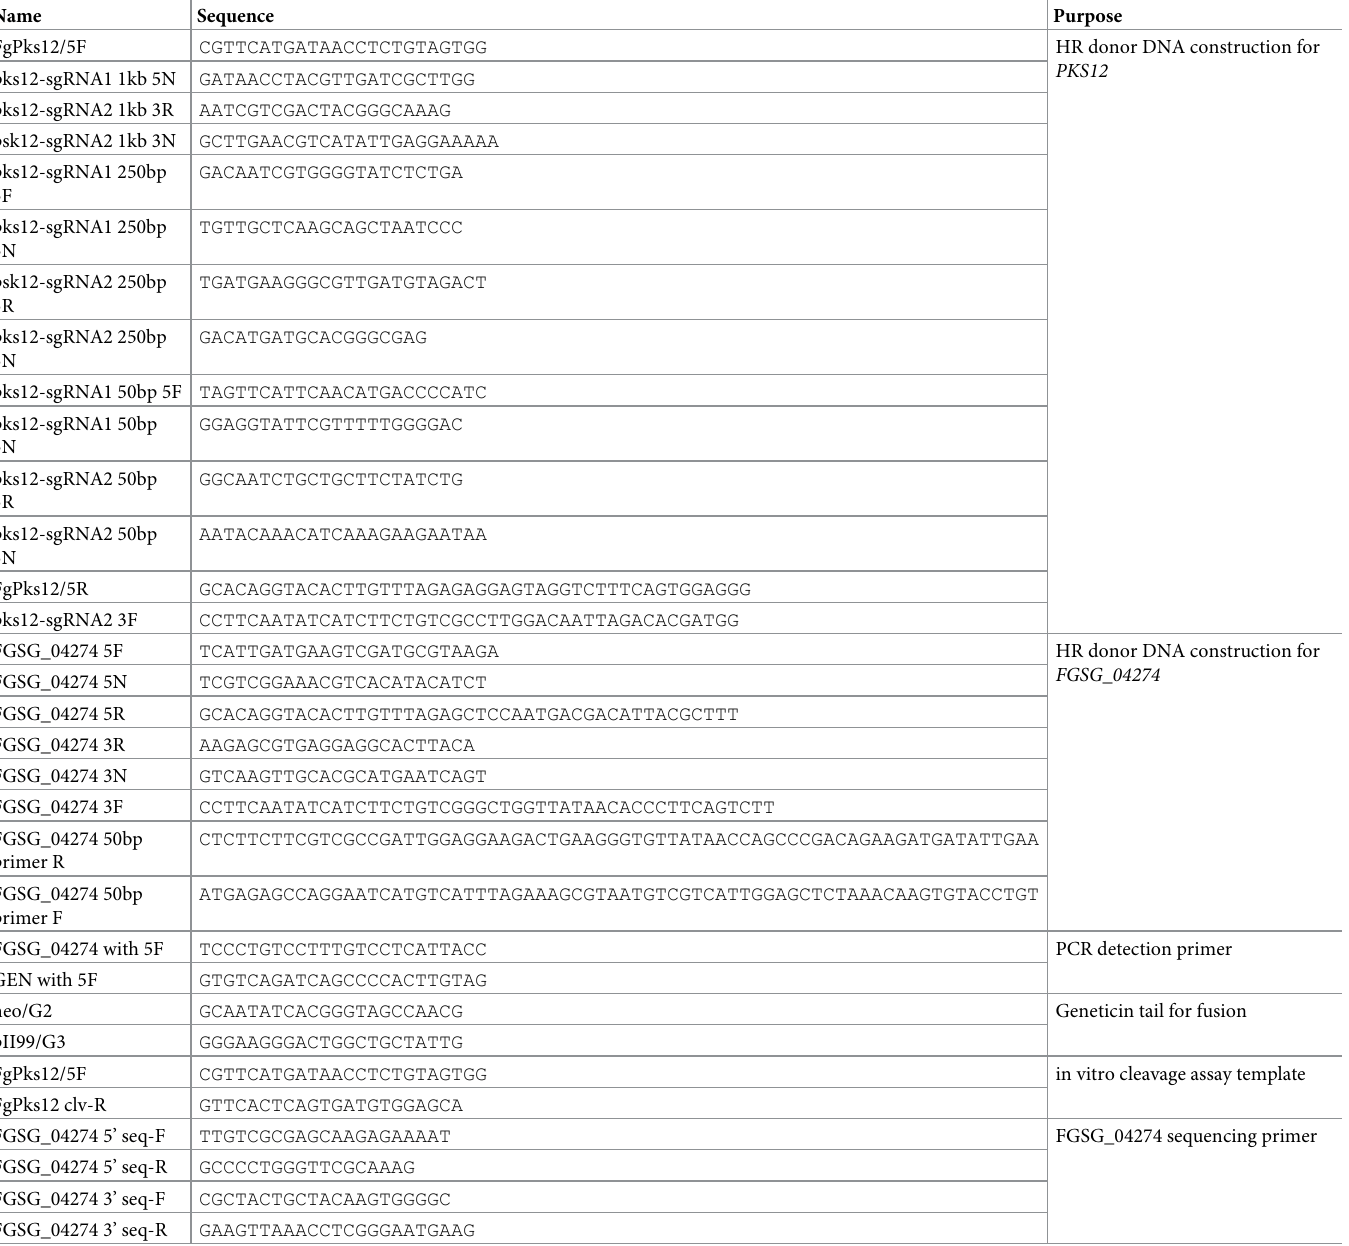
Table 1. Primers used in this